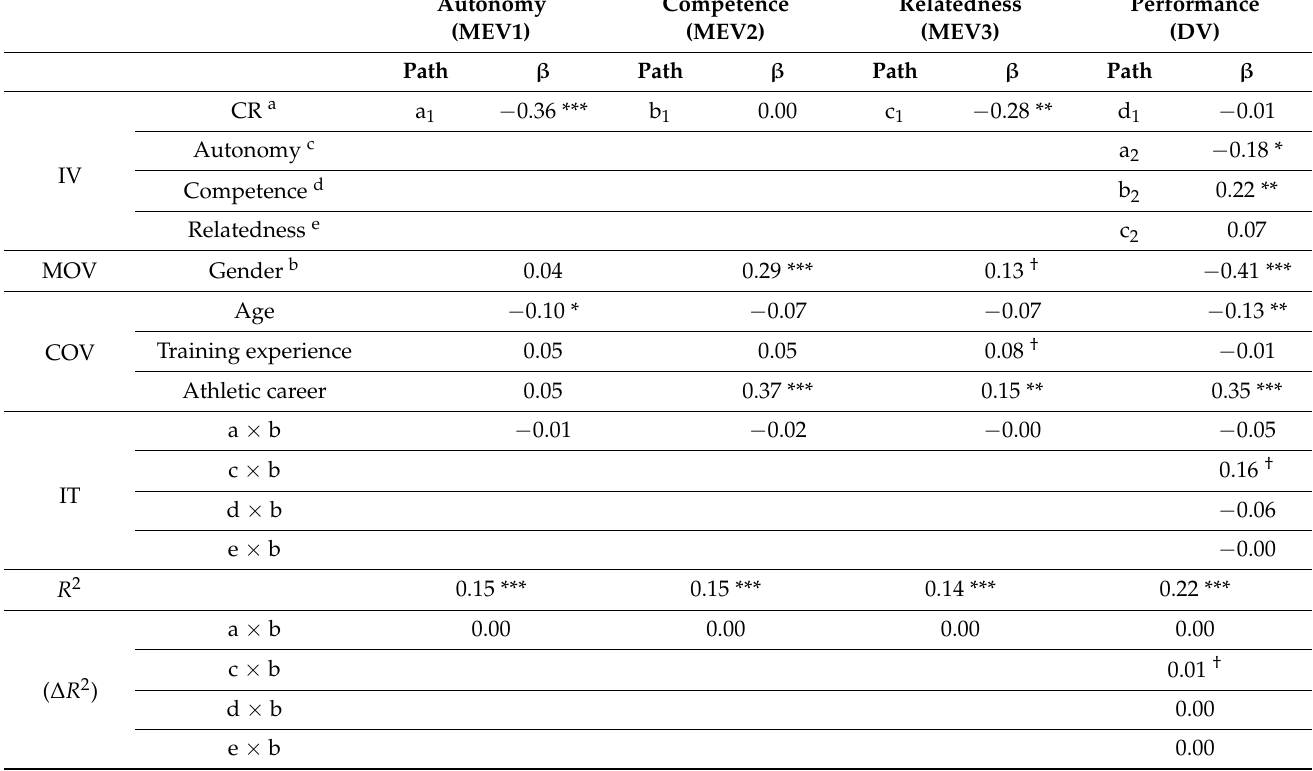
Table 3. Regression coefficients and model summary information for multi mediated moderation (IV =